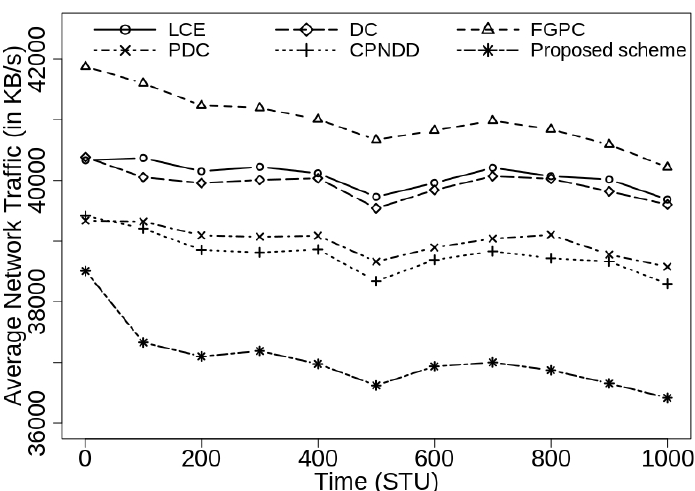
Figure 10. Comparison of average network traffic (in KB/s) with λ = 50/s, | CS ( R i ) | = 50, α = 0.7, and | Ctlg | = 5000.